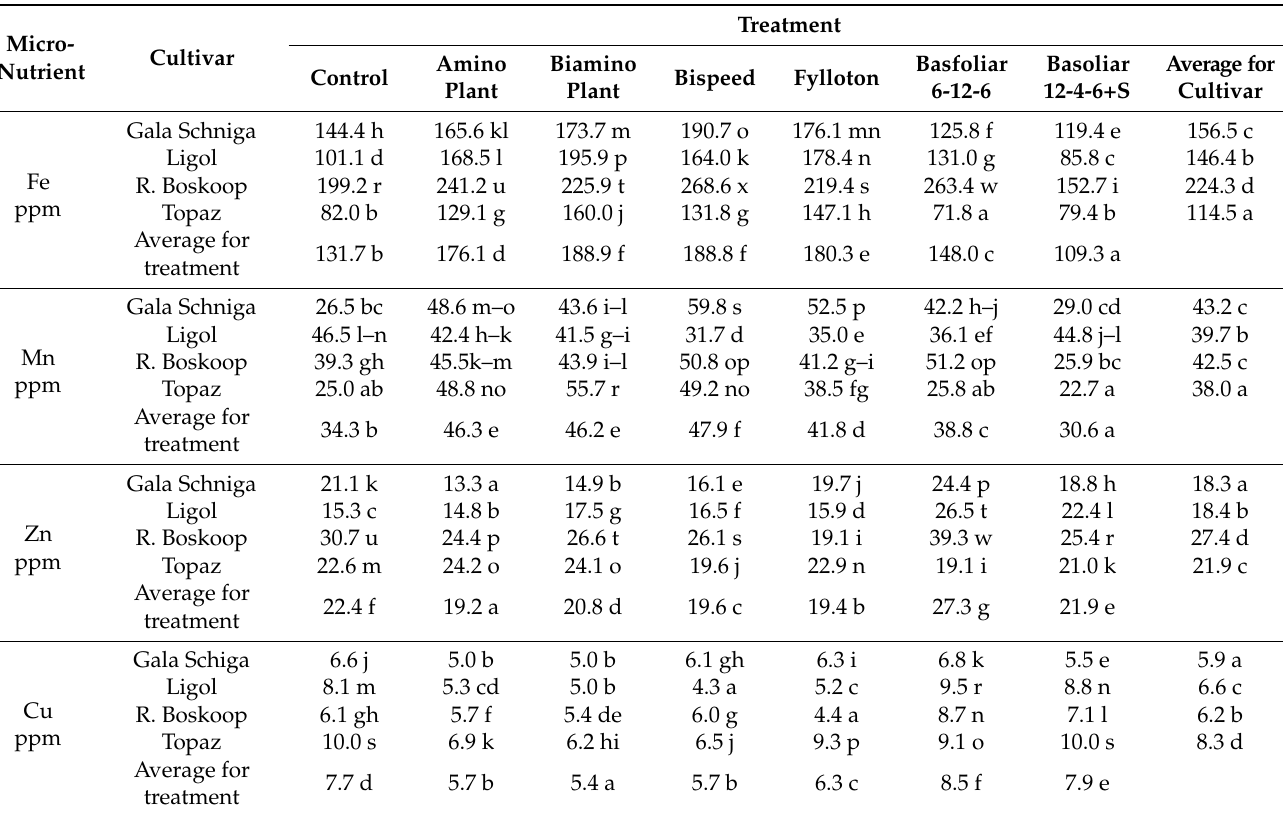
Table 5. The contents of micronutrients in the leaves of maiden apple